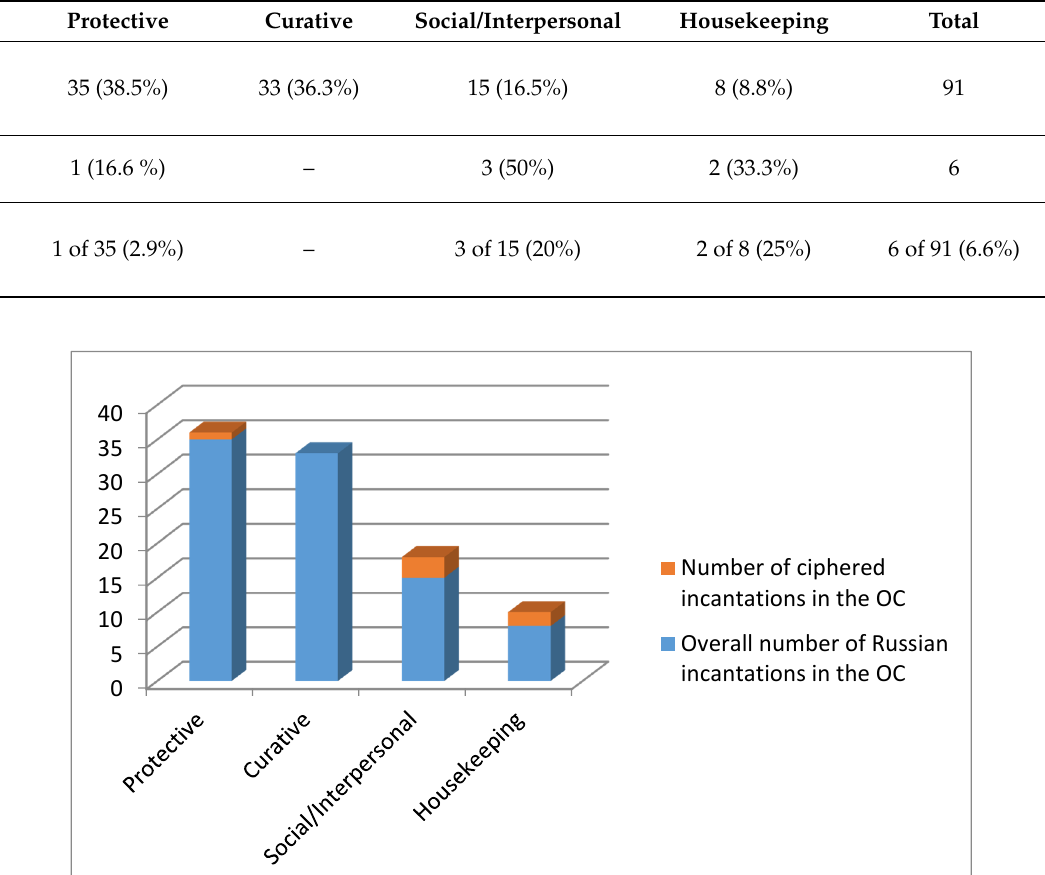
Table 2. Statistic of ciphered Russian incantations in the OC.